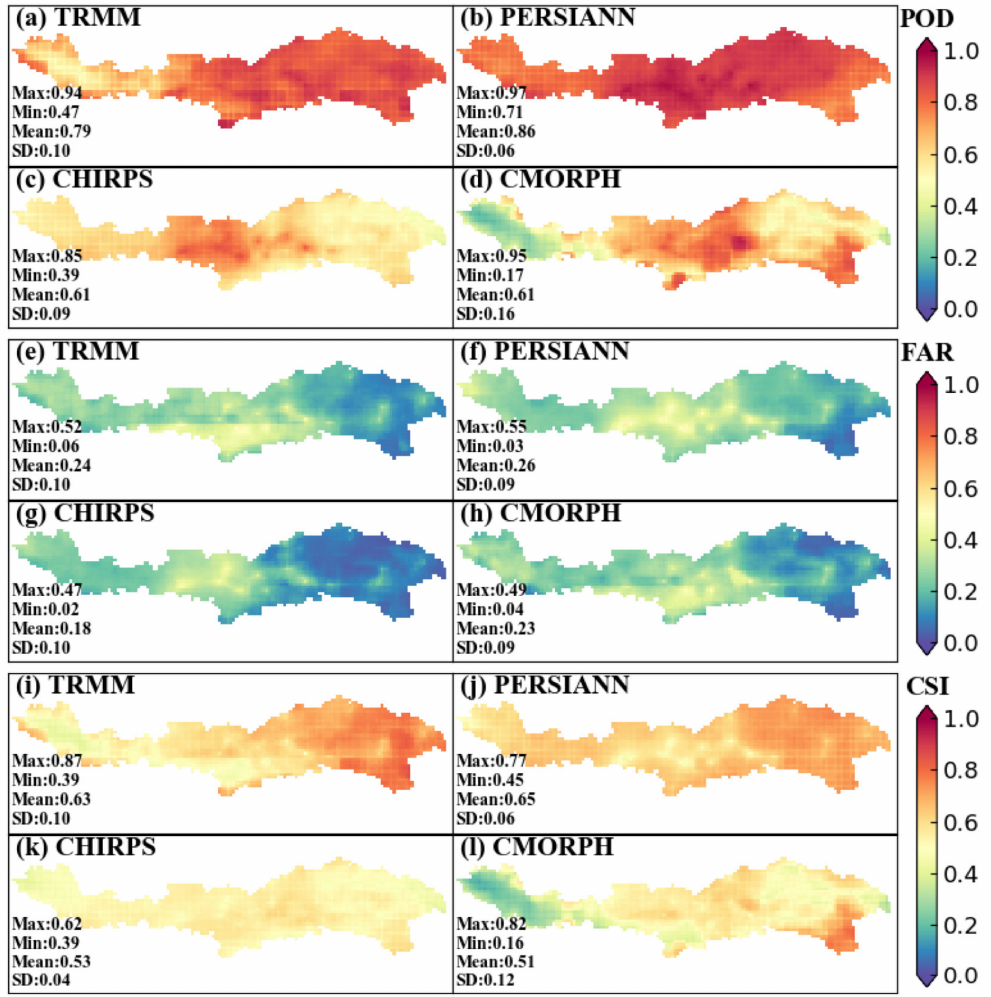
Figure 5. Spatial distribution of precipitation detection ability metrics (POD, FAR, CSI) of daily precipitation during 2000–2008: ( a – d ) spatial distribution of POD values; ( e – h ) spatial distribution of FAR values; ( i – l ) spatial distribution of CSI